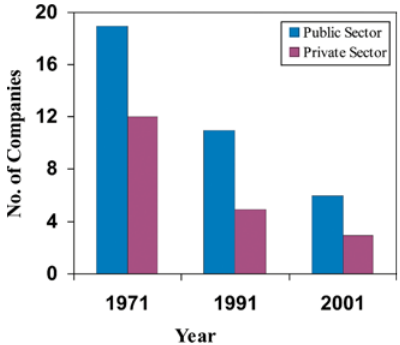
Figure 1. Primary Vaccine Suppliers to the Indian EPI in the Last Four Decades The data were compiled from the annual reports of Health Information of India